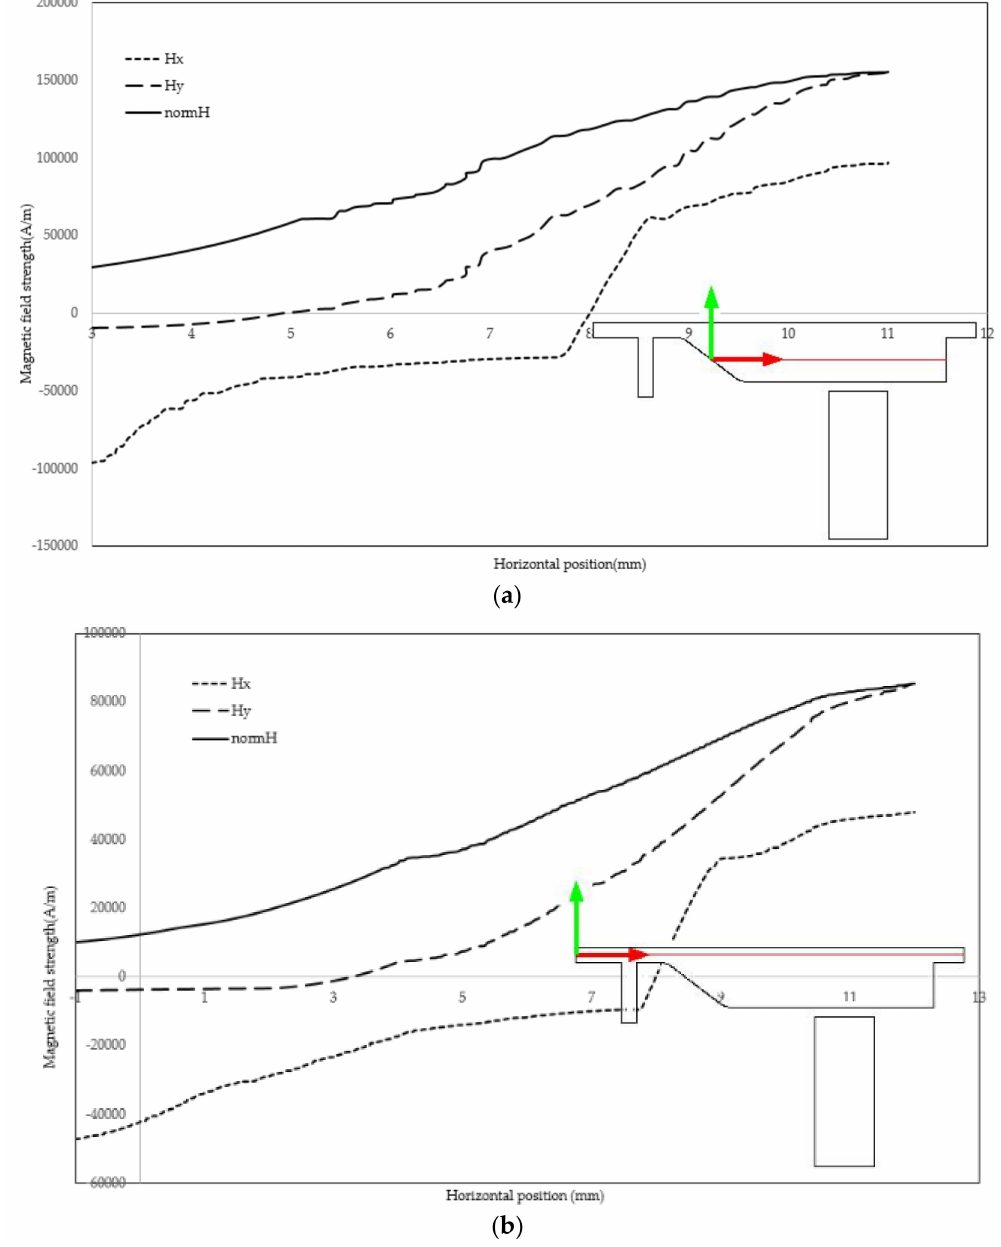
Figure 14. The magnetic field strength: ( a ) field magnitude in vicinity of bottom wall; and ( b ) field magnitude in vicinity of top